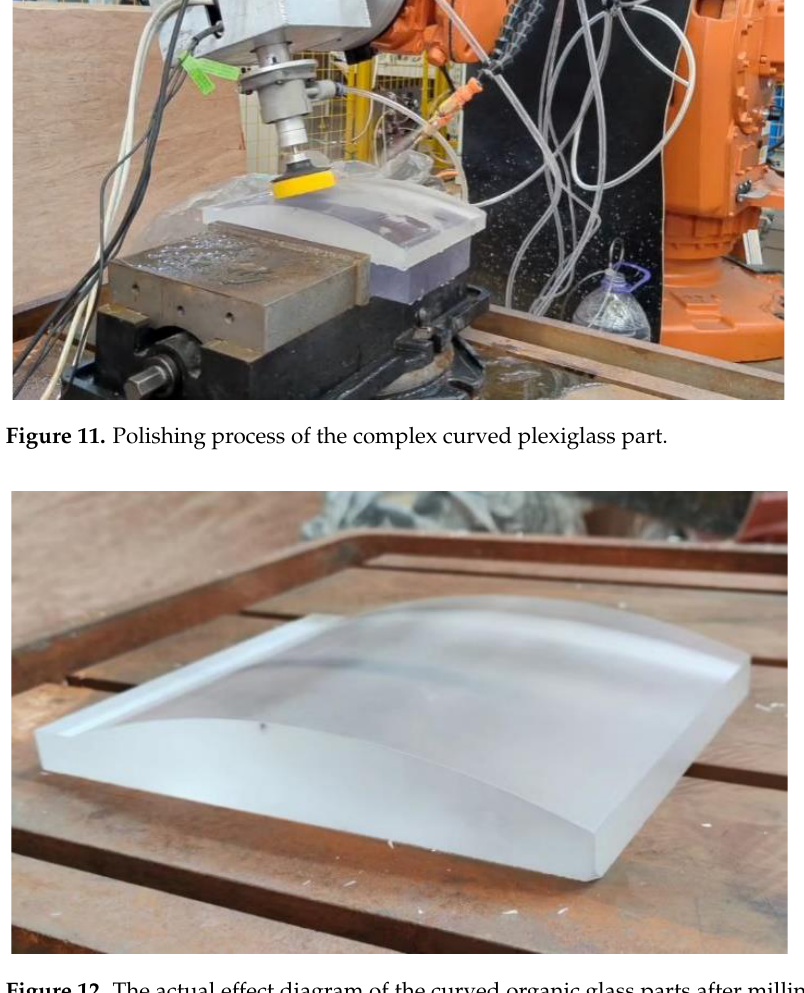
Table 3. Planning of polishing process.